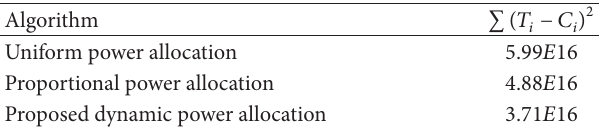
Table 6: System’s total squared difference for the three algorithms in Scenario